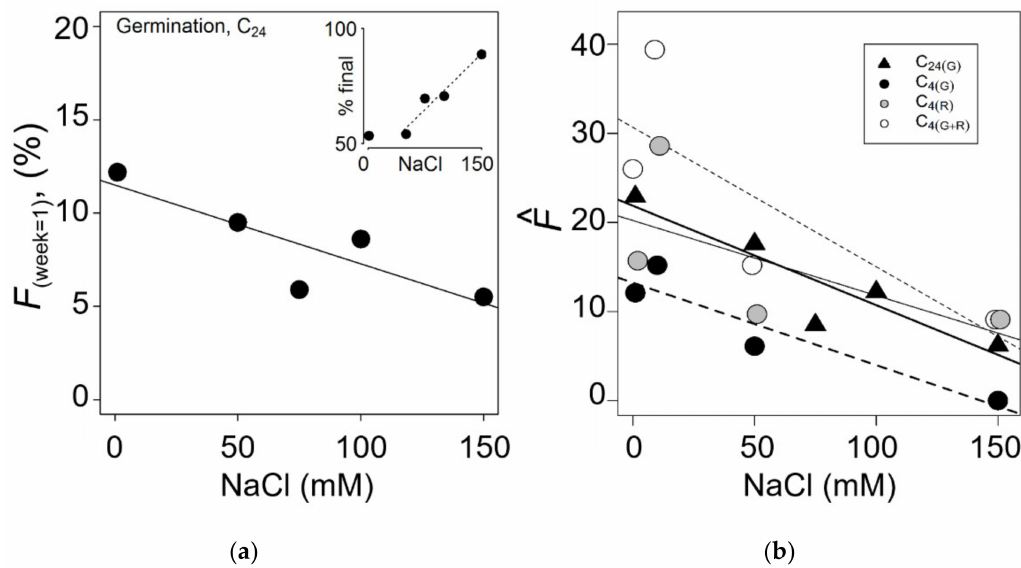
Figure 5. ( a ) Salinity and C 24 first-week germination probability, F ( week = 1 ) ; y = − 0.04 ns x + 11.5**, r 2 adj = 0.633, p > 0.067, n = 5. Inset: salinity and relative germination risk for 1st week relative to final germination (in percent), % final = 100 · F ( week = 1 ) / ˆ F ; for 50–150 mM NaCl salinity range, y = 0.32* x + 40.3**, r 2 adj = 0.915, p < 0.029, n obs = 4. ( b ) Linear regression between salinity and ˆ F in the trials (G = germination, R = recovery): solid bold , C C 4 , r 2 adj = 0.76, p < 0.034*; solid , C 4(R) , r 2 adj = 0.37, p < 0.105 ns ; densely dashed , C 4(G + R) , r 2 adj =